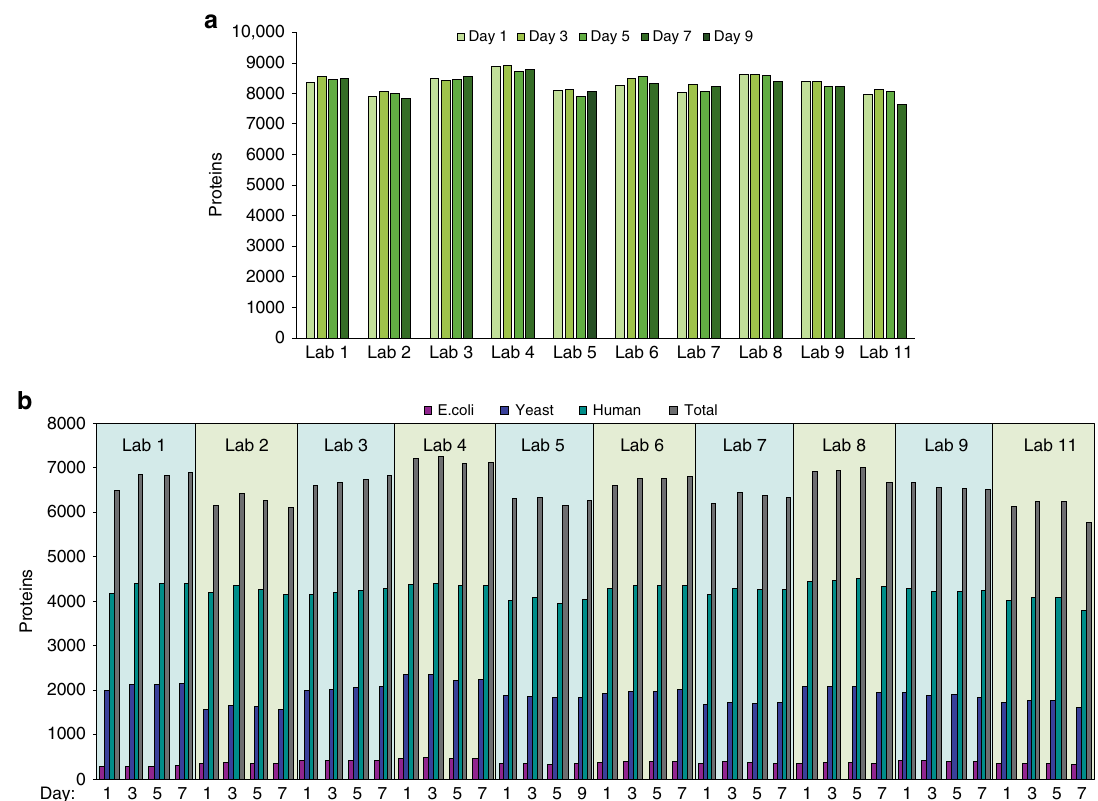
Fig. 3 Overall performance of QC-benchmarked HRMS1-DIA work fl ow. a The number of proteins identi fi ed in both samples A and B (with a 1% FDR) at each laboratory was plotted over the 7-day evaluation period (indicated by shades of green). b The number of proteins quanti fi ed in total and for each individual organism in controlled samples (based on criteria described in the Methods section) at each laboratory is plotted over the 7-day evaluation period. Quanti fi ed proteins are shown in purple for E.coli, in blue for yeast, in green for human and in gray for total. For laboratory 5, which had an extended evaluation period of 9 days, due to technical issues detected, addressed, and resolved during day 7, the identi fi cation ( a ) and quanti fi cation ( b ) results obtained for day 9 substitutes those of day 7. Source data are provided as a Source Data fi